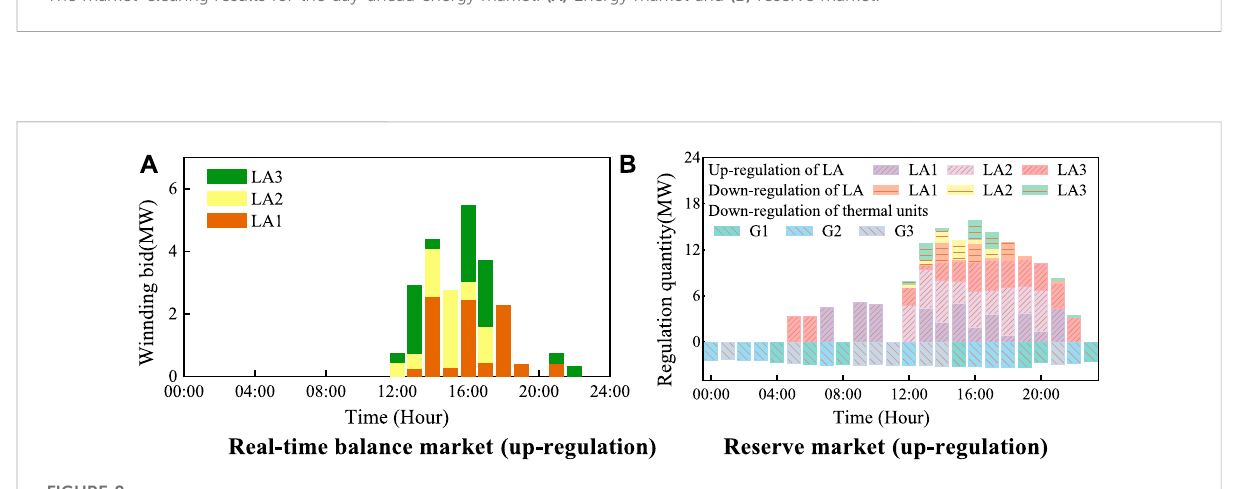
FIGURE 8 The regulation status for balance and reserve resources under scenario one. (A) Real-time balance market (up-regulation) and (B) reserve market